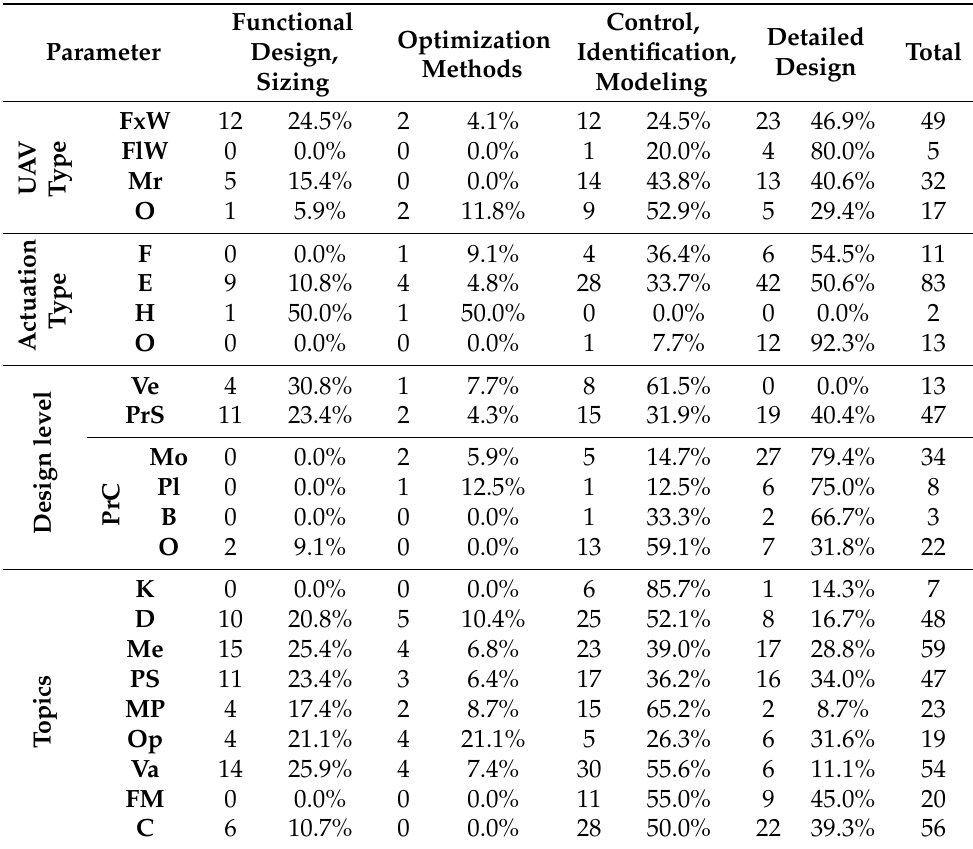
Table 12. Synthesis of the literature review, according to the taxonomy referring to the paper content. From the left, the analyzed parameters and the evaluated categories. For each category, the absolute number of papers assessing the characteristics and percentage are reported in the left and right column,